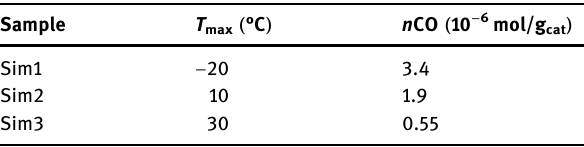
Table 5: Estimation of the number of surface metal sites by amount of CO desorbed at low temperatures